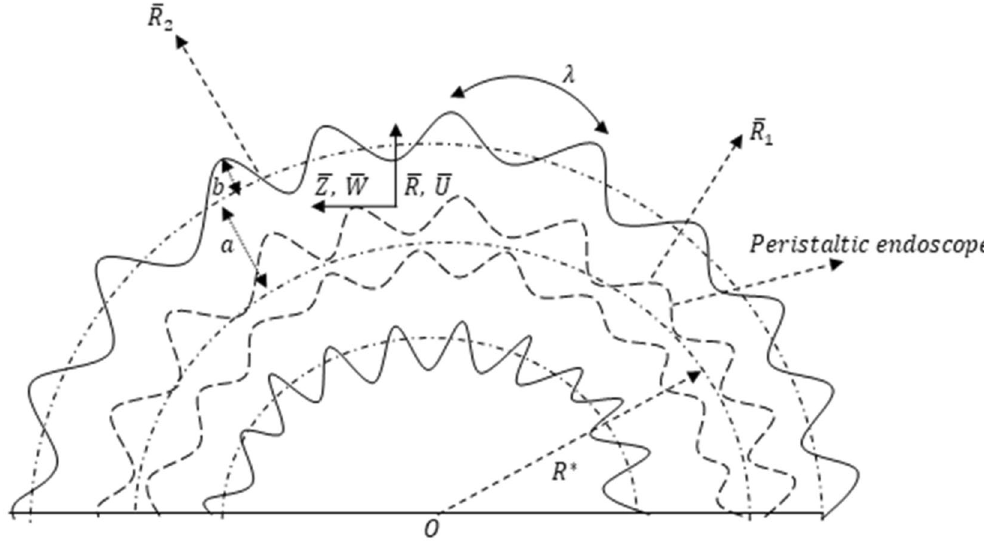
Figure 1. Geometrical model of the